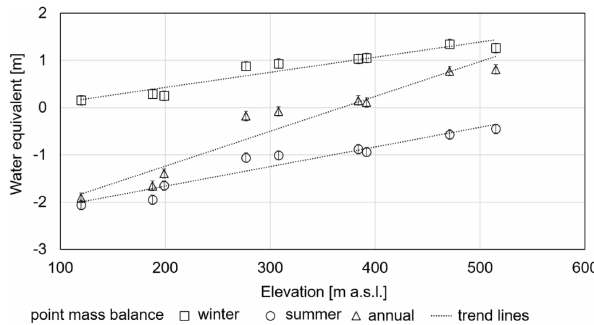
Figure 4. Examples of winter, summer and annual point mass bal- ance on Werenskioldbreen (season 2010–2011). Whiskers show an error (total differential